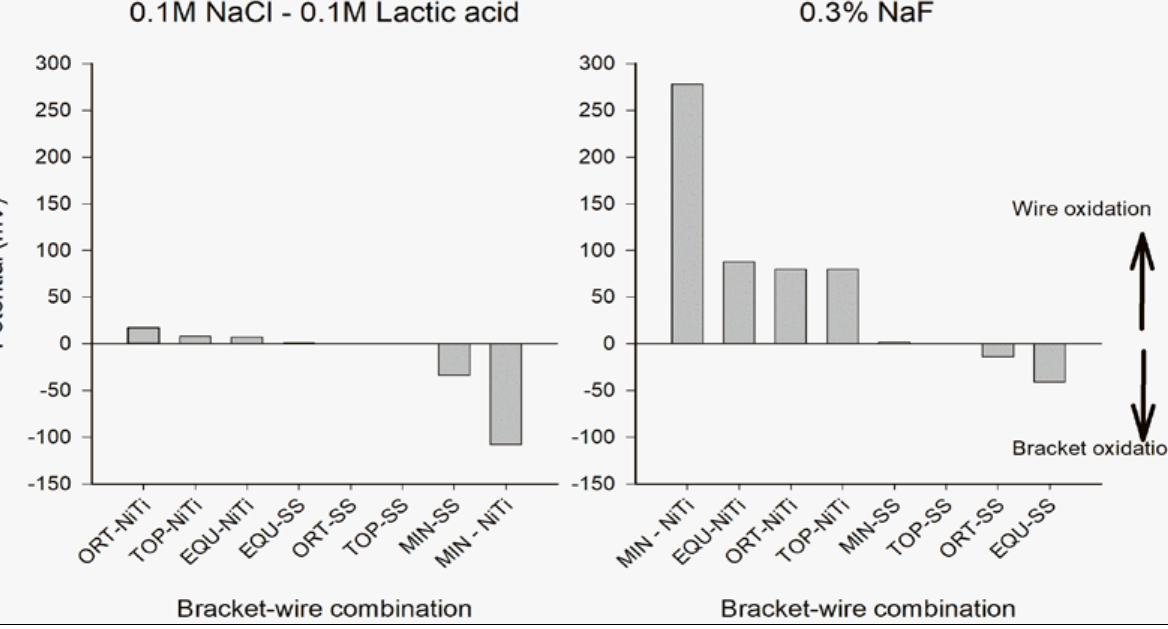
Figure 3. Mean potential differences for all bracket-wire combinations in descending order from left to right in both solutions tested. In all cases the standard deviations were found to be less than 23 mV and they are not presented for the sake of clarity. Positive mean values denote wire oxidation while negative depict bracket oxidation as shown by the